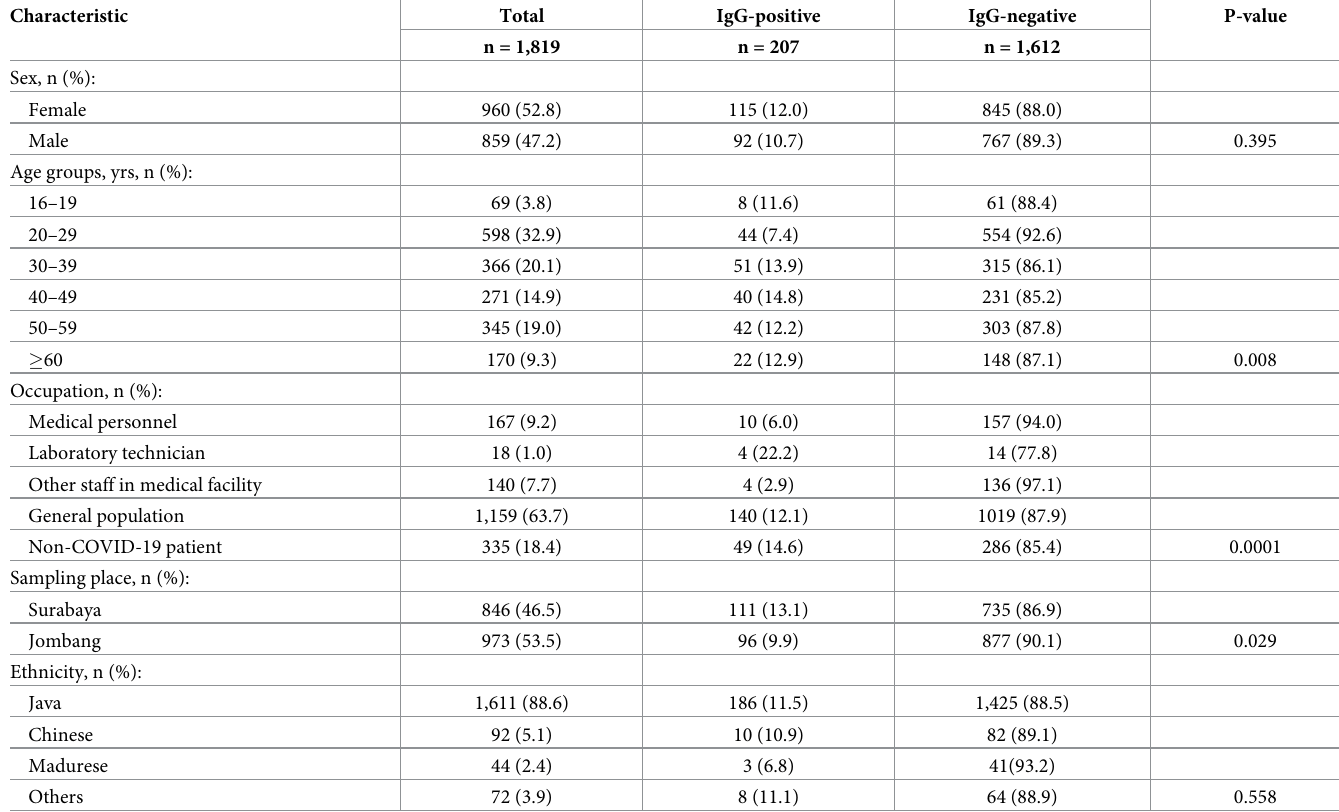
Table 1. Demographic characteristics and IgG positivity of the